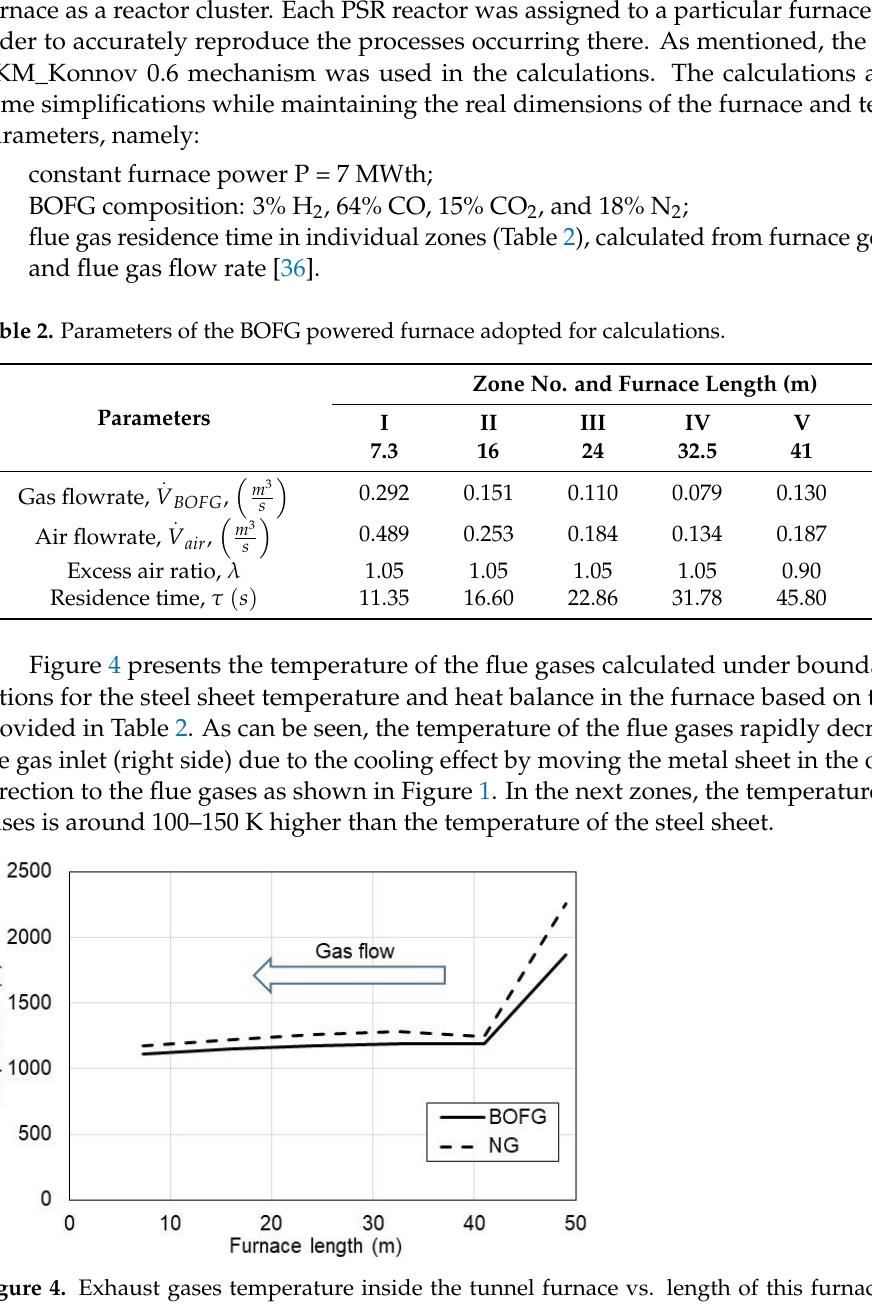
Table 2. Parameters of the BOFG powered furnace adopted for calculations.